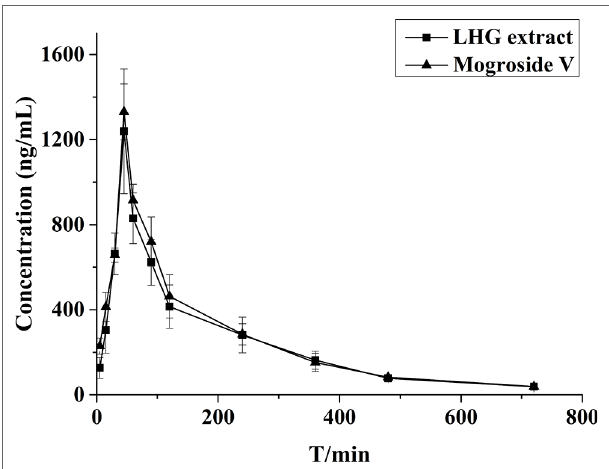
FIGURE 7 | Mean plasma concentration–time profiles of rats after oral administration of mogroside V (200 mg/kg) and LHG extract (12.5 ml/kg).